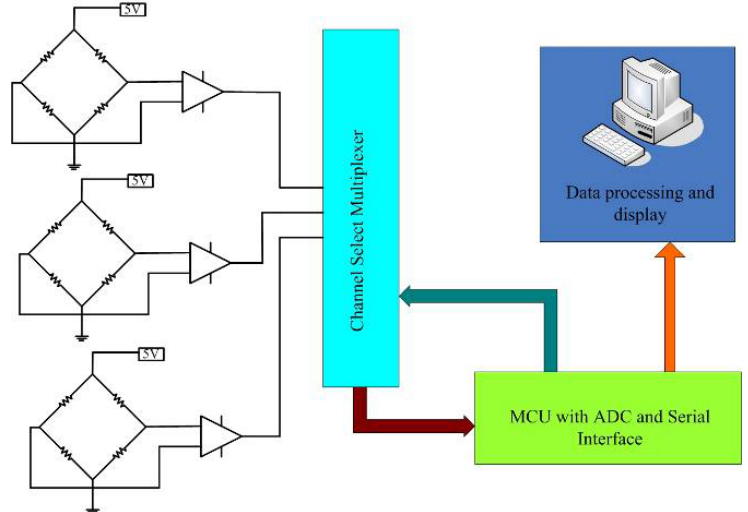
Figure 10. Schematic diagram of the conditioning